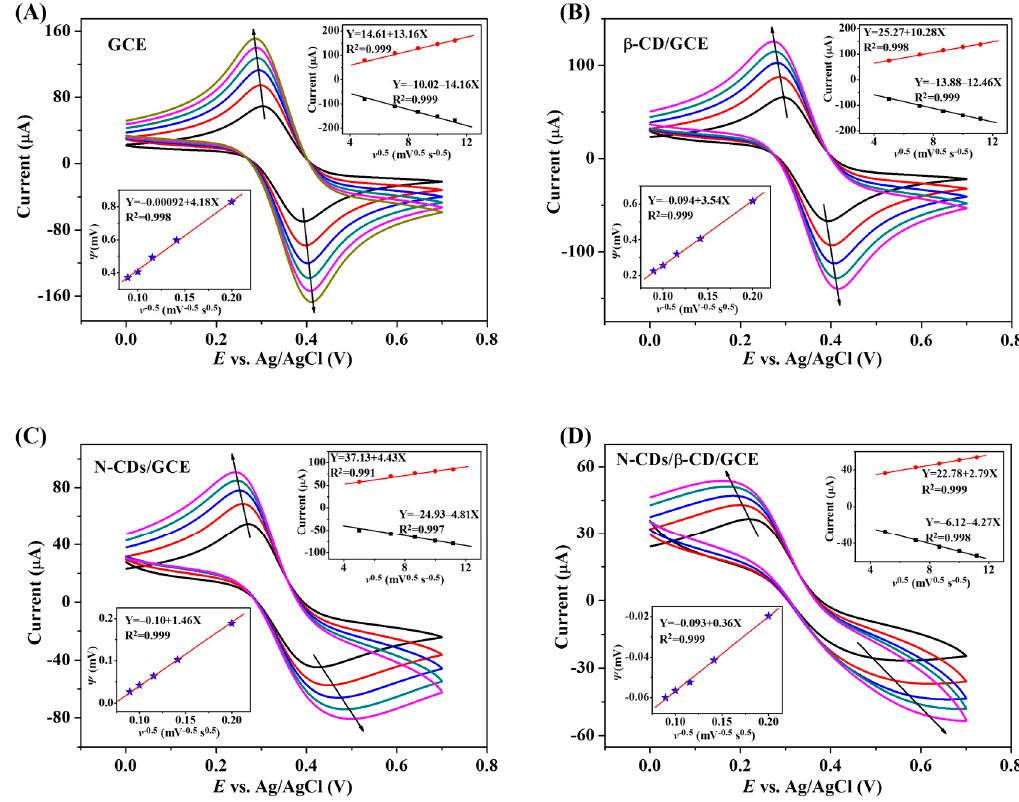
Figure 5. CVs and associated kinetic analyses at bare GCE ( A ); β -CD/GCE ( B ); N-CDs/GCE ( C ) and N-CDs/ β -CD/GCE ( D ) in 5.0 mM [Fe(CN) 6 ] 3 − / 4 − solution containing 0.1 M KCl. The inserts are the corresponding plots of ψ − v − 0.5 curves and I − v 0.5 curves. Sweep rates: 25, 50, 75, 100 and 125 mV·s − 1 .